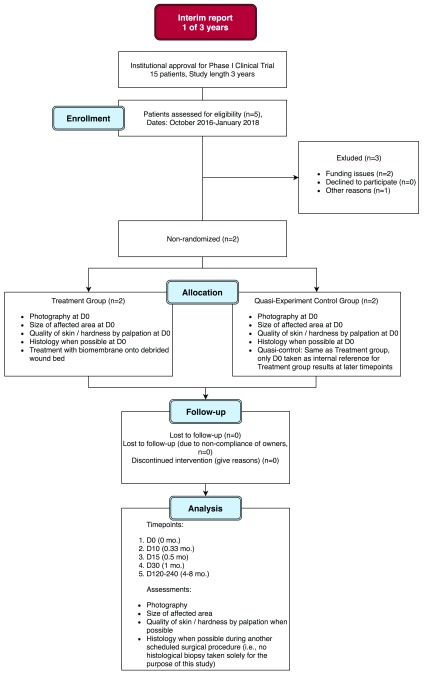
Study flow diagram.